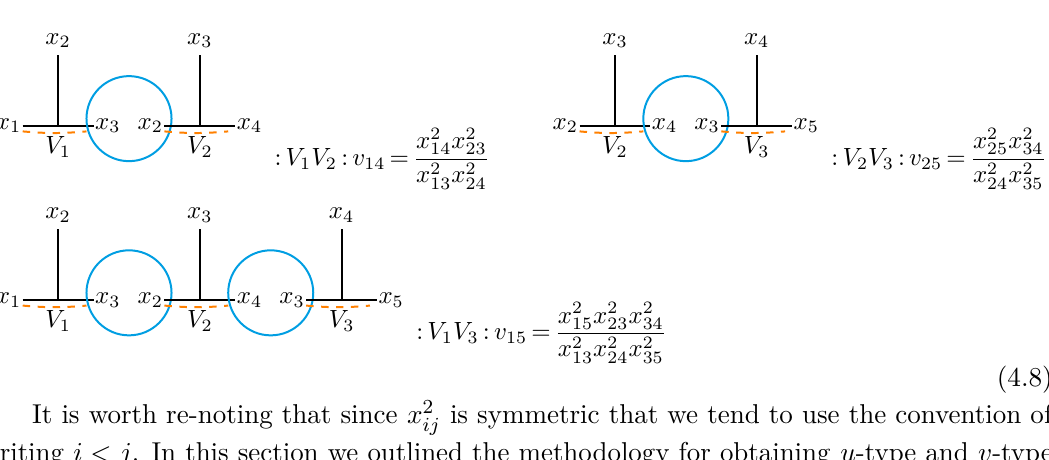
Figure 9 . (a) A canonical M -point AdS diagram, and (b) the associated ( M − 1) -point diagram. We have left the external insertion points implicit — an operator of dimension ∆ at position x . The shaded blobs labeled 3 and M represent arbitrary tree-level subdiagrams. The i shaded blobs 3 0 and M 0 have the same topology as their unprimed counterparts with all external and internal dimensions replaced by their primed counterparts. The precise relation between the primed and unprimed conformal dimensions will be explained later in this